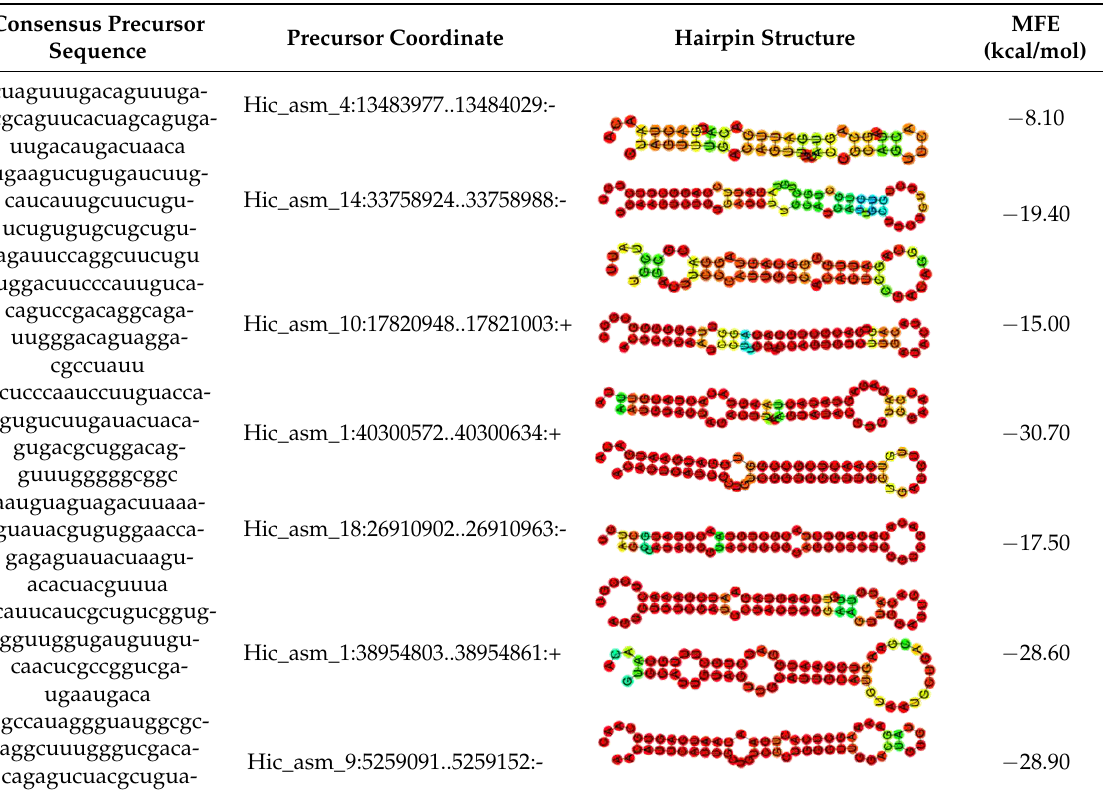
Table 2. The precursor sequence, precursor coordinate on C. altivelis genome, and predicted hairpin structures of novel miRNAs.